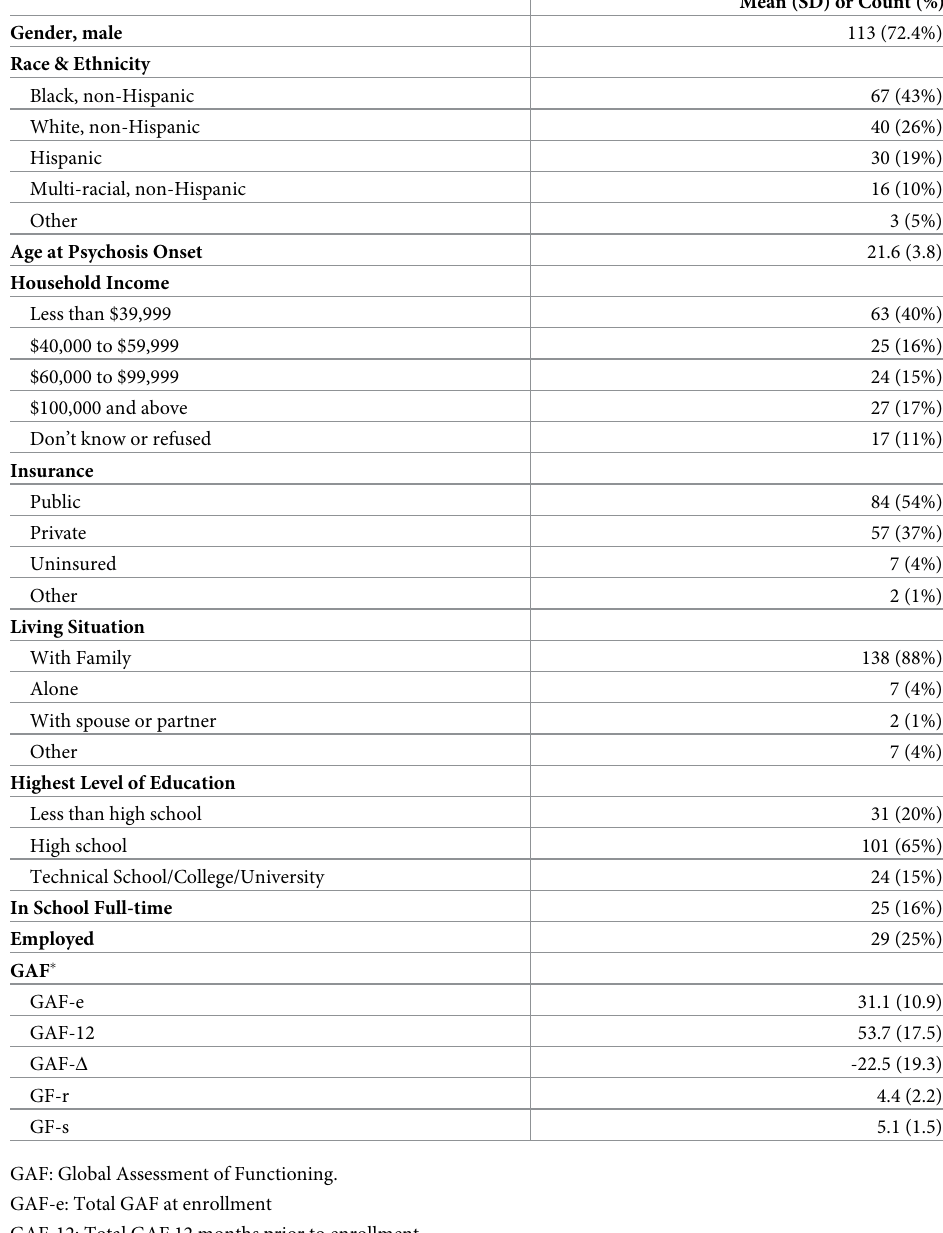
Table 1. Demographic and clinical characteristics of participants. (n =